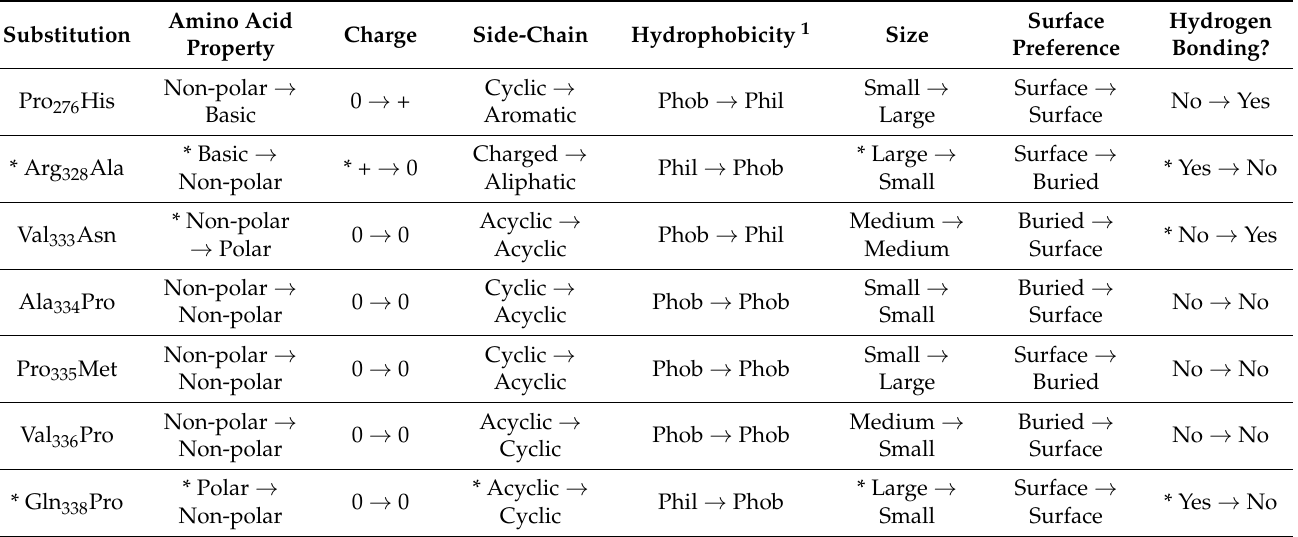
Figure 6. Modelling and three-dimensional comparison of the “276” region of wild-type AHSV and BTV VP7. Targeted amino acids are coloured individually in surface comparisons ( A,B ) and side-chain comparisons of each residue ( C,D ) for AHSV and BTV respectively. Residue properties are compared between AHSV and BTV VP7 via colour elements in each side-chain (blue = nitrogen; red = oxygen; cyan = carbon; yellow = sulphur) ( E,F ). Table 2. Substitutions made in the 276 region and their resulting changes in chemical and functional features. Asterix (*) indicates significant feature changes.